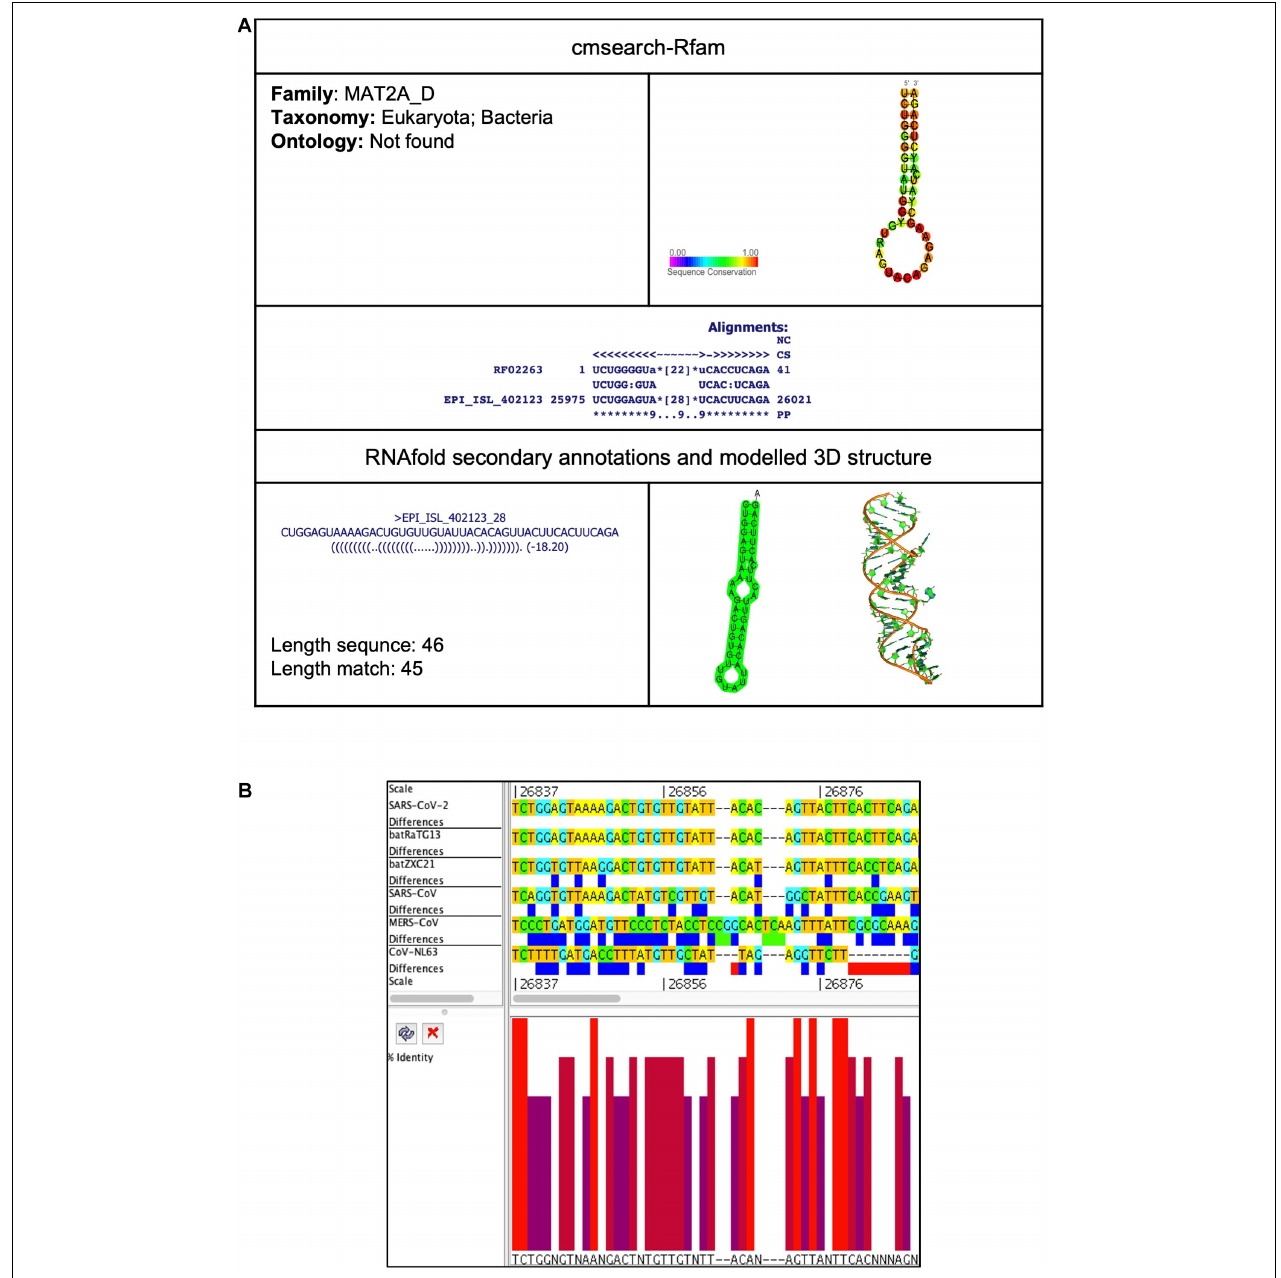
FIGURE 5 | MAT2A_D cis -acting RNA element in the SARS-CoV-2 genome. (A) The sequence and RNA structure of MAT2A_D is located in position 25,975–26,021 of the SARS-CoV-2 genome. In the 3-D structure, the phosphodiester backbone is shown in orange, and the nucleotides are shown in the sticks and filled rings with elemental coloring as C green, O red, and N blue. (B) Conservation of MAT2A_D RNA sequence from various CoVs. The MAT2A_D is located as aligned position 26,837–26,888. The navy blue box indicates mismatched nucleotides between the two sequences, and the red box indicates gaps between two sequences. Percentage identity in the histogram in which red indicates a perfect match and magenta indicates the low similarity of